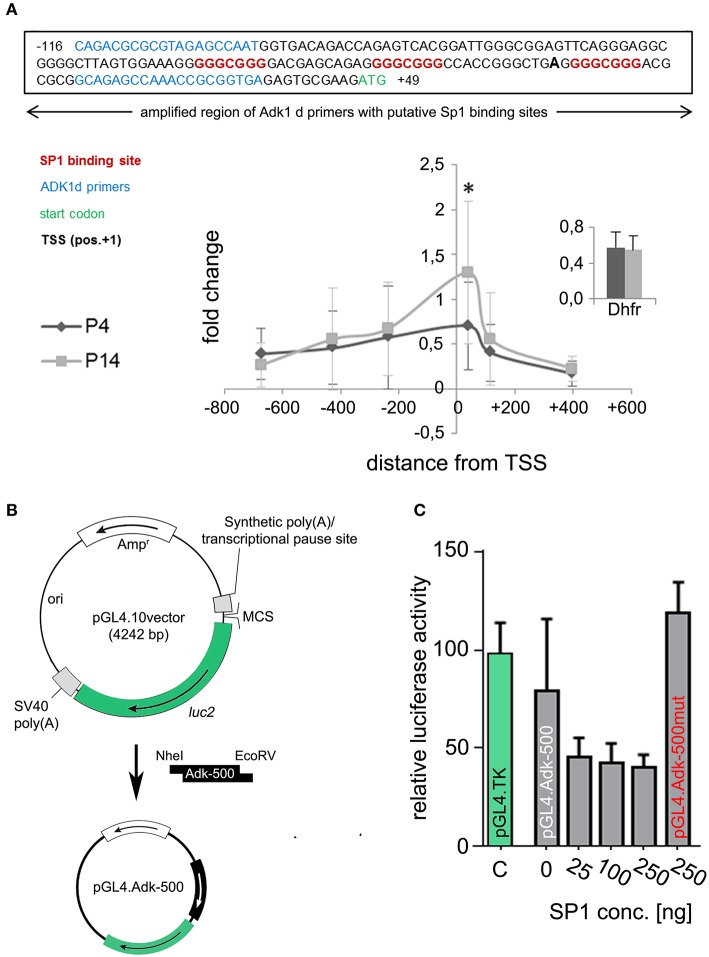
Identification of transcription factor binding. (A) Upper panel: SP1 binding sites (indicated in red) at the amplified region of Adk 1d primers (indicated in blue) around the TSS (pos. +1, bold). Lower panel: Binding of SP1 to the promoter region of the long Adk isoform are shown relative to a positive control primer in P4 and P14 rat hippocampal neurons. The analyzed promoter region spanned over 1 kb between position −735 and +470 relative to the TSS. There is significant enrichment of SP1 binding around the TSS of the Adk-L promoter in P14 rat hippocampal neurons, which may be implicated in the suppression of the long Adk isoform. Inset displays enrichment of positive control for Sp1 antibody presented as percent of the total input chromatin (% input). (B) Luciferase assay was performed to analyze the binding of SP1 to the Adk promoter and its impact on gene expression. Therefore, the Adk-L promoter including 1.000 bp upstream the TSS was subcloned in front of luciferase 2 (luc2) gene in the pGL4.10 vector and transfected into HEK293 cells. Transfected cells were incubated with increasing concentrations of recombinant SP1 for 3 h and then used for luciferase activity measurements. (C) We identified a concentration dependent negative regulation of the Adk-L promoter and luc2 gene through transcription factor SP1. Adk, Adenosine kinase; Adk-L promoter, promoter regulating expression of the long Adk isoform; Ap3m1, adaptor-related protein complex 3, mu 1 subunit; ChIP, chromatin immunoprecipitation; CpG, cytosine guanine dinucleotide; DHFR, Dihydrofolate reductase; kb, kilobase; SP1, specificity protein 1;TSS, transcriptional start site. *indicates significance.